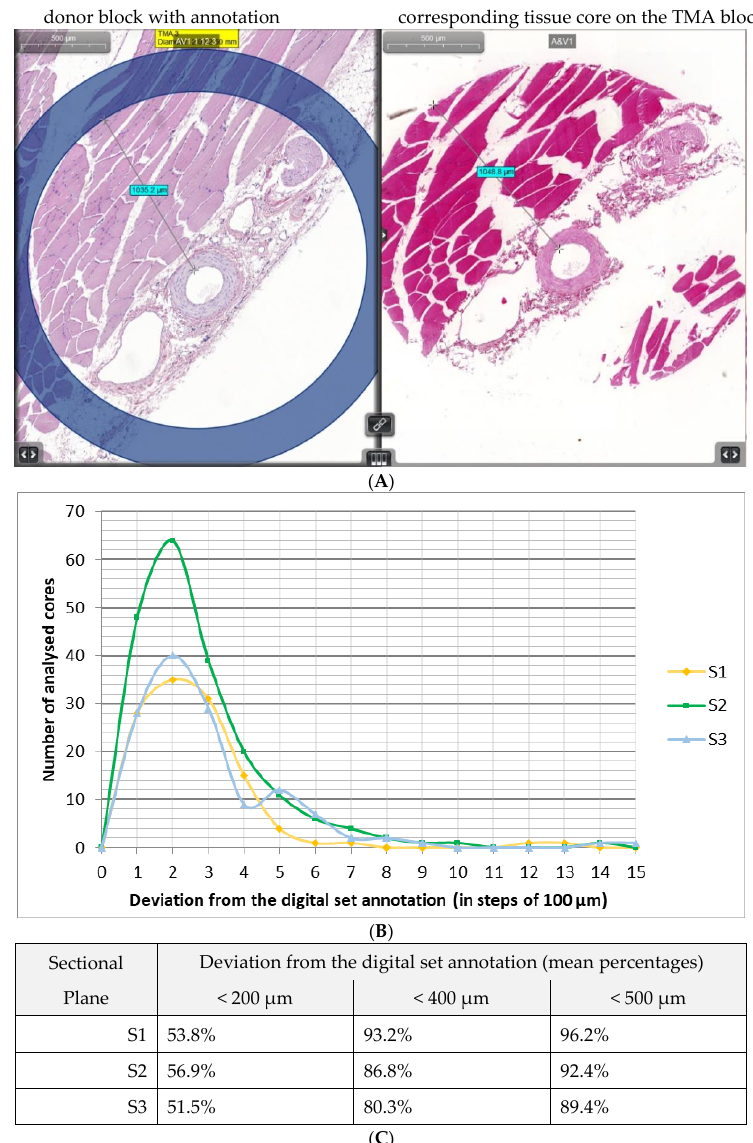
Figure 7. Quantitative Accuracy. ( A ) Example for the determination of the quantitative accuracy. The distance between a target structure on the H&E slide of a donor block and the inner margin of the set annotation was measured and compared to the length with the respective measures in the TMA-Slide. Shown here is an example of outstanding accuracy, with a difference of less than 100 µ m. ( B ) The graph shows the deviation between the digitally set annotation and the TMA Slide. The number of punch cores analysed was plotted against the deviation of these cores in the different sectional planes (S1, S2, S3). The coding of the deviation on the horizontal axis is as follows: 1 0–99 µ m deviation; 2 100–199 µ m deviation; etc. ( C ) The table shows the distribution of the accuracy in the different sectional planes (S1, S2,